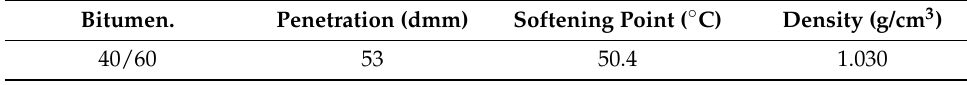
Table 1. Bulk mass properties of bitumen.